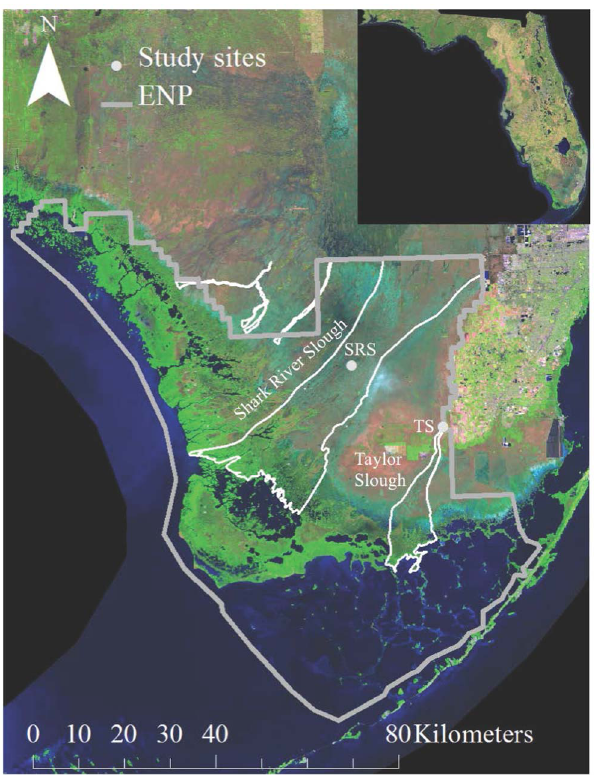
Fig. 1. Short- (TS) and long- (SRS) hydroperiod freshwater marsh sites within Everglades National Park, Florida, U.S.A. This map was developed using files created by the Florida Coastal Everglades (http://fcelter.fiu. edu/data/GIS) and LandSat imagery, 2004 LandSat 7 ETM 3-4-5 Statewide Mosaic UTM, made available by the South Florida Water Management District